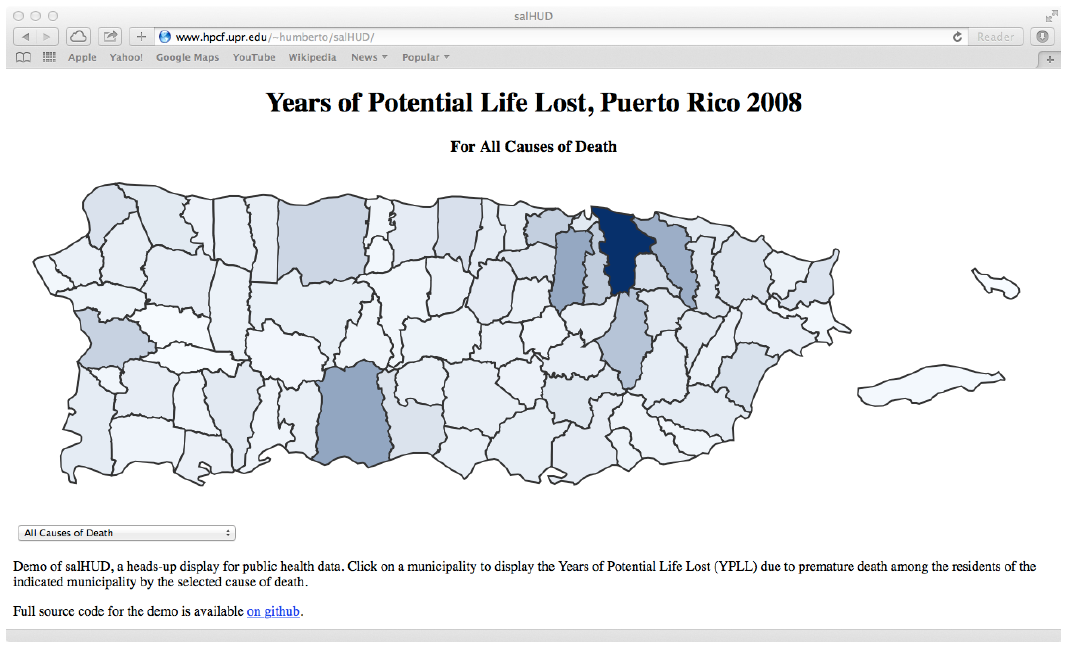
Figure 3. Screenshot of the SalHUD demo application showing the total YPLL for Chronic Lower Respiratory Airway Disease in the municipality of Ponce in 2008. A video of the application is available at https://www.youtube.com/watch?v=YIXvXLQTZFw. A working prototype is available at: http://www.hpcf.upr.edu/ humberto/salHUD/. The full source code for the application is available as well [12].